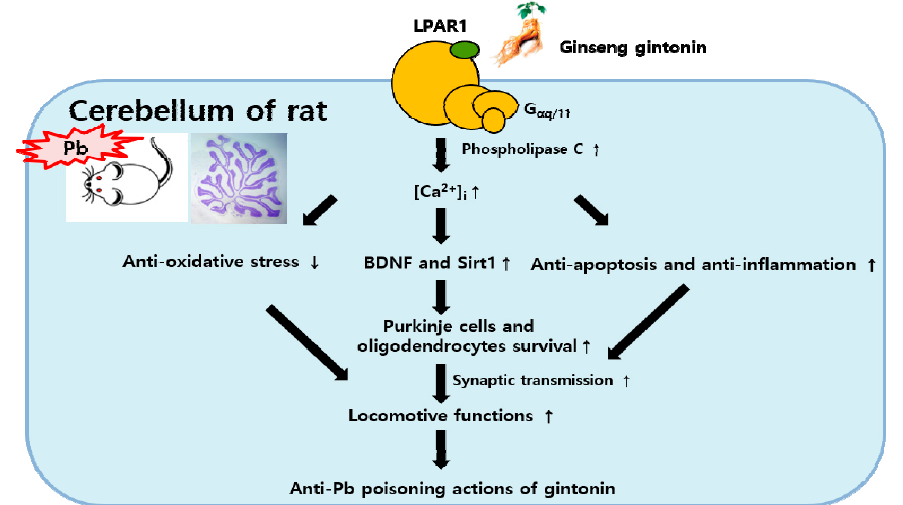
Figure 8. Schematic illustration of gintonin-mediated anti-Pb effects. Cerebellar LPAR1 expression was reduced after Pb exposure, which was reversed by gintonin treatment. Gintonin-mediated anti-Pb effects could be mediated through three mechanisms: antioxidant stress, increased BDNF and Sirt1, and anti-apoptosis/inflammation via activation of LPAR1 signaling pathways. The convergence of these three beneficial mechanisms could increase the survival of cerebellar Purkinje cells and oligodendrocytes, facilitating synaptic transmission. These beneficial effects of gintonin contribute to the locomotive recovery in pups from Pb-poisoned dams.